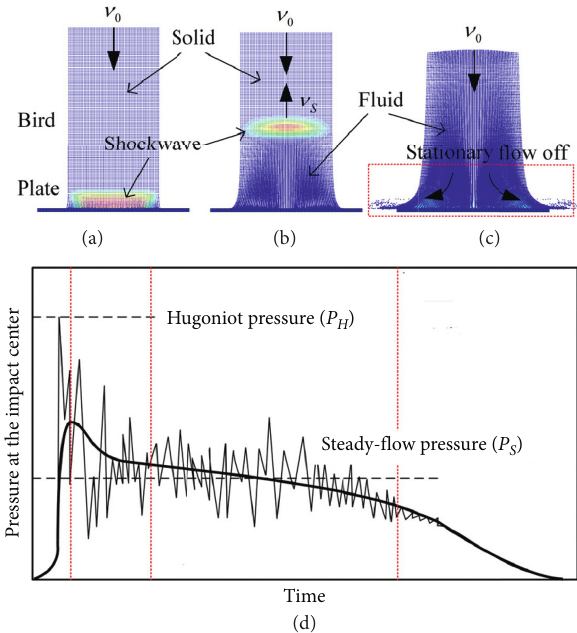
Figure 1: Main phases and pressure profile of a bird strike event. (a) Solid-structure impact. (b) Solid-fluid transition. (c) Fluid- structure impact. (d) Impact pressure